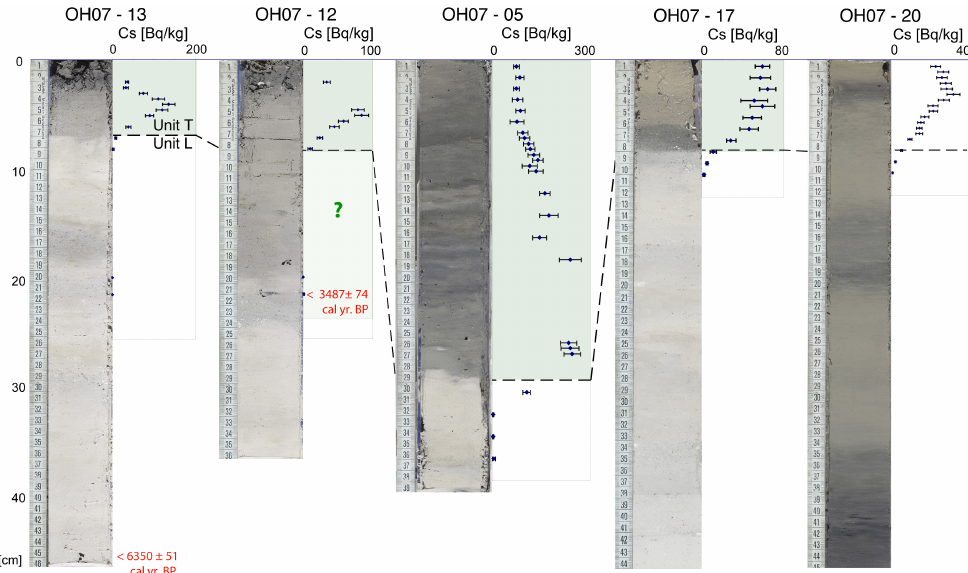
Fig. 8. Photographs and 137 Cs activities of selected cores. Green shade indicates Unit T. Note the absence of 137 Cs just below the Unit L-Unit T boundary. Red numbers indicate radiocarbon ages (Table 3). Unit assignment in core 12 is not straightforward as indicated by a question